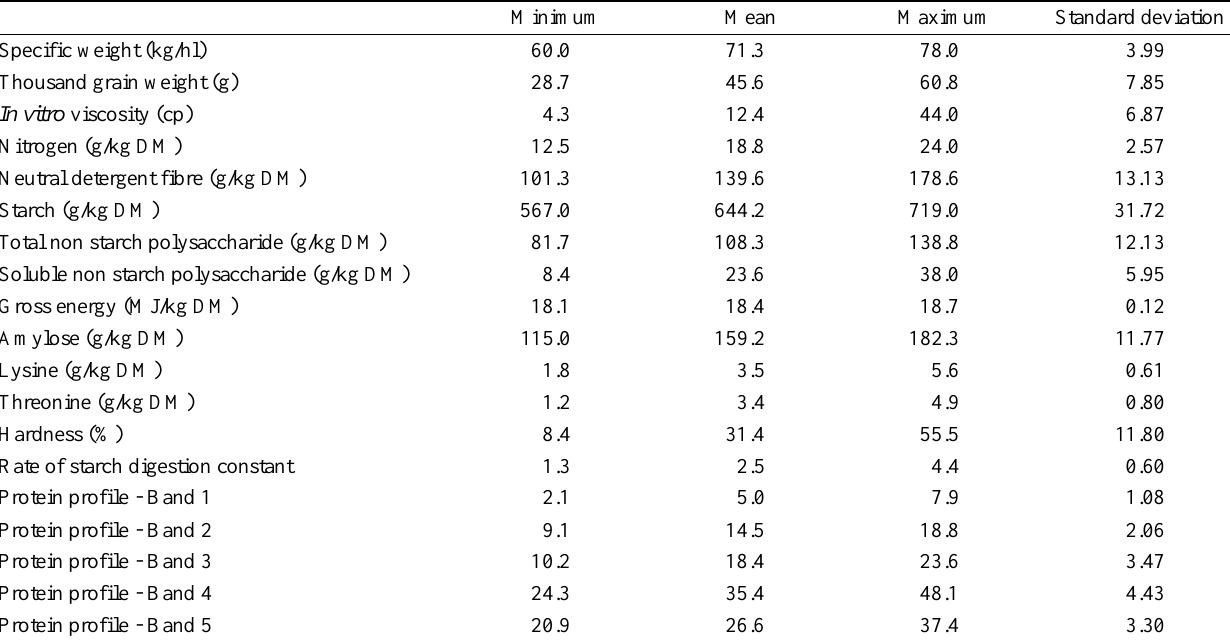
Table 2. Range and standard deviation of chemical and physical parameters of wheat Minimum Mean Maximum Standard deviation Specific weight (kg/hl)